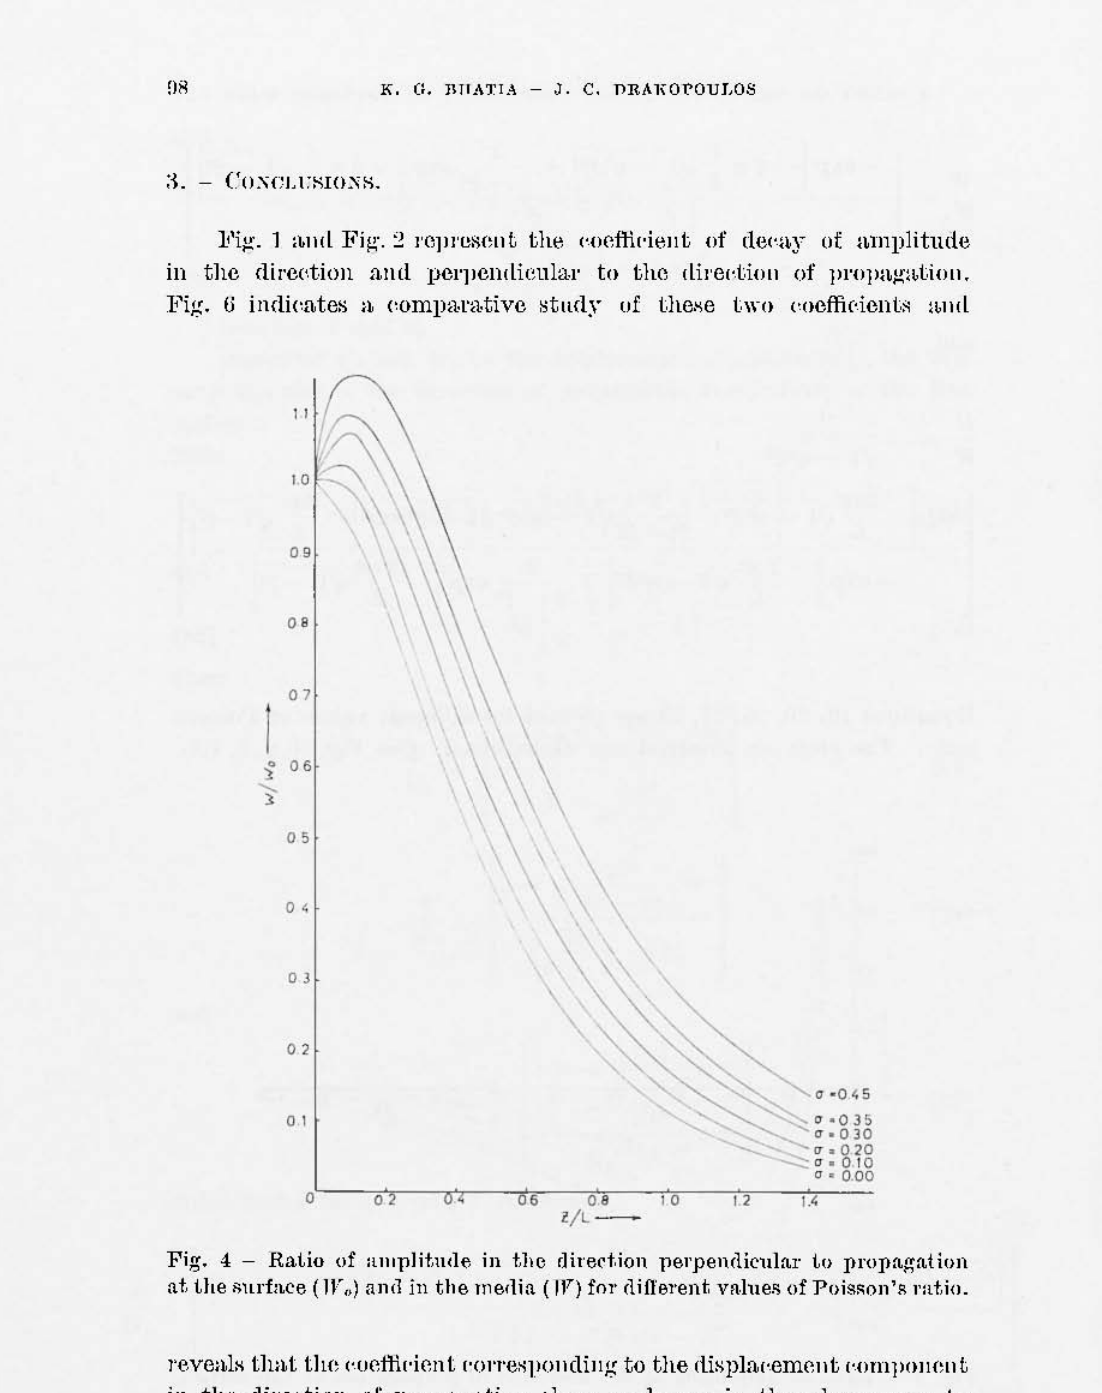
Fig. 4 - Ratio of alllplitulle in tllC rlired.ion perpendieular to propagation at the ;;urfare (IV,,) and in the Tne,lia (W) fol' difIel'ent values of Pois~on's ratio. revcals tlmt tlte ('ocftì('icnt ('ol'J'esponding to the (lispla('cmcnt ('OHl])(II!ellt in the dil'ct'tiOll or pI'OII;~g'ation f;how a ('lmng-e in the ph;~He llelH